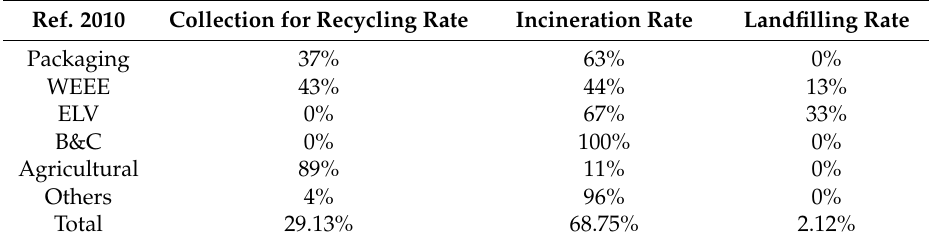
Table 4. Share of plastic waste generation, by waste stream